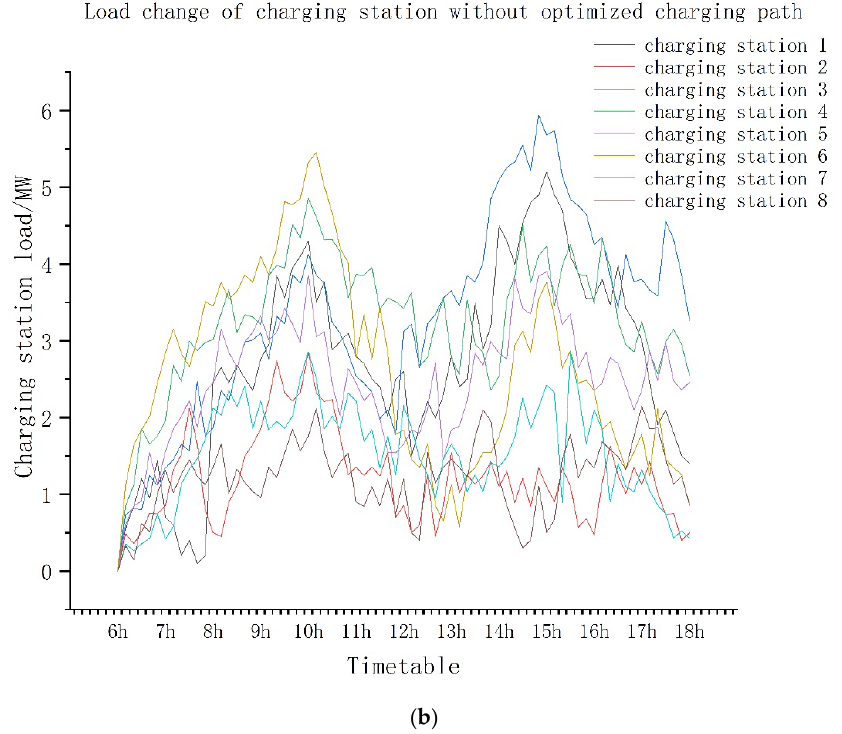
Figure 10. Eight charging stations’ load changes with time. ( a ) Load change of charging station under navigation of optimal charging path; ( b ) load changes at charging stations without optimized charging strategy.